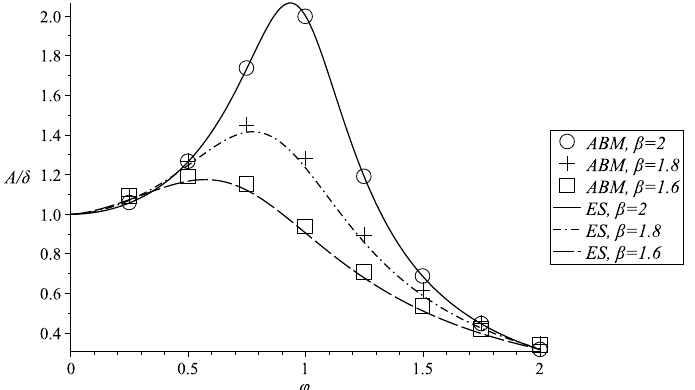
Figure 4. Resonance curves plotted for different values of the parameter β by Formula (43) and by the ABM method.